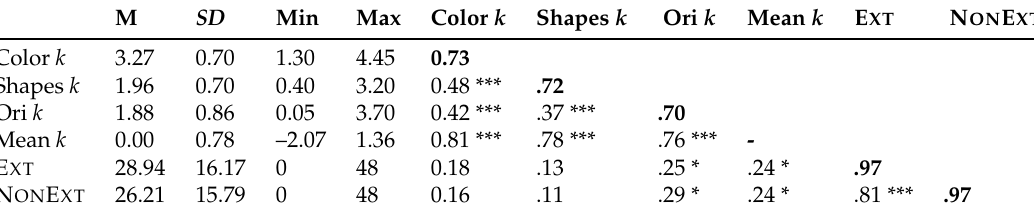
Table 2. Descriptives and correlations of fluid intelligence and storage capacity.